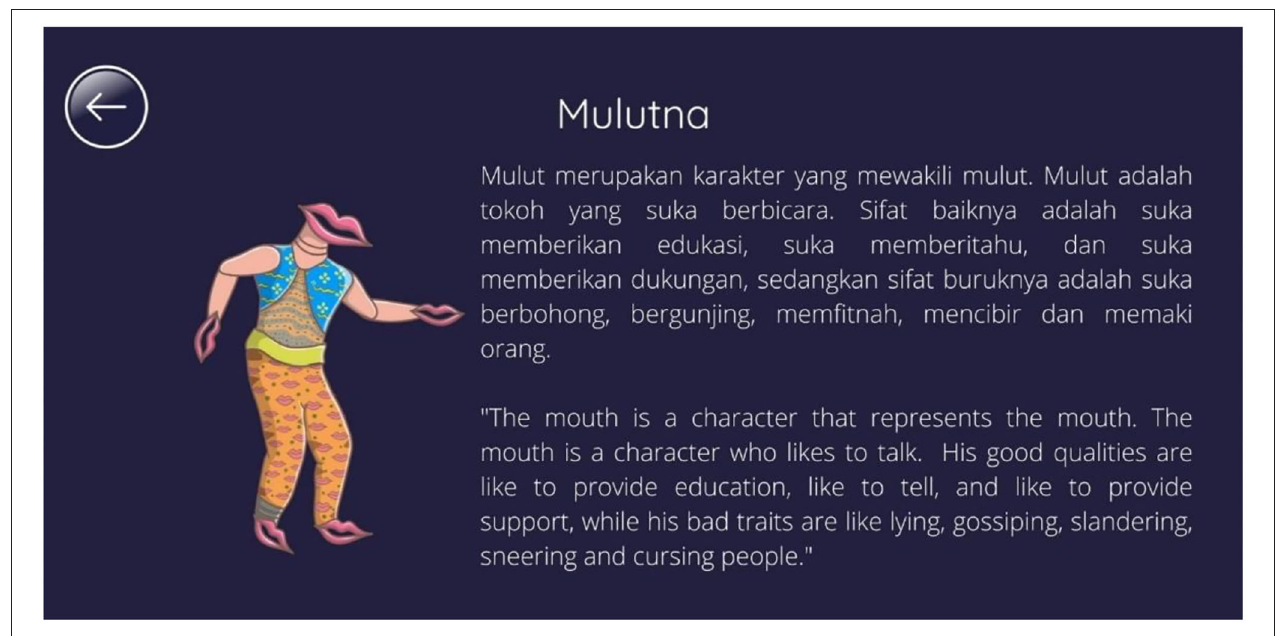
FIGURE 3 | Bi Iwir/the mouth character in the character feature application.